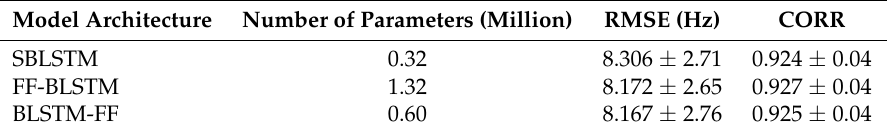
Table 4. Objective results of best model in each network architecture ( ± denotes standard deviation and RMSE denotes root mean-squared